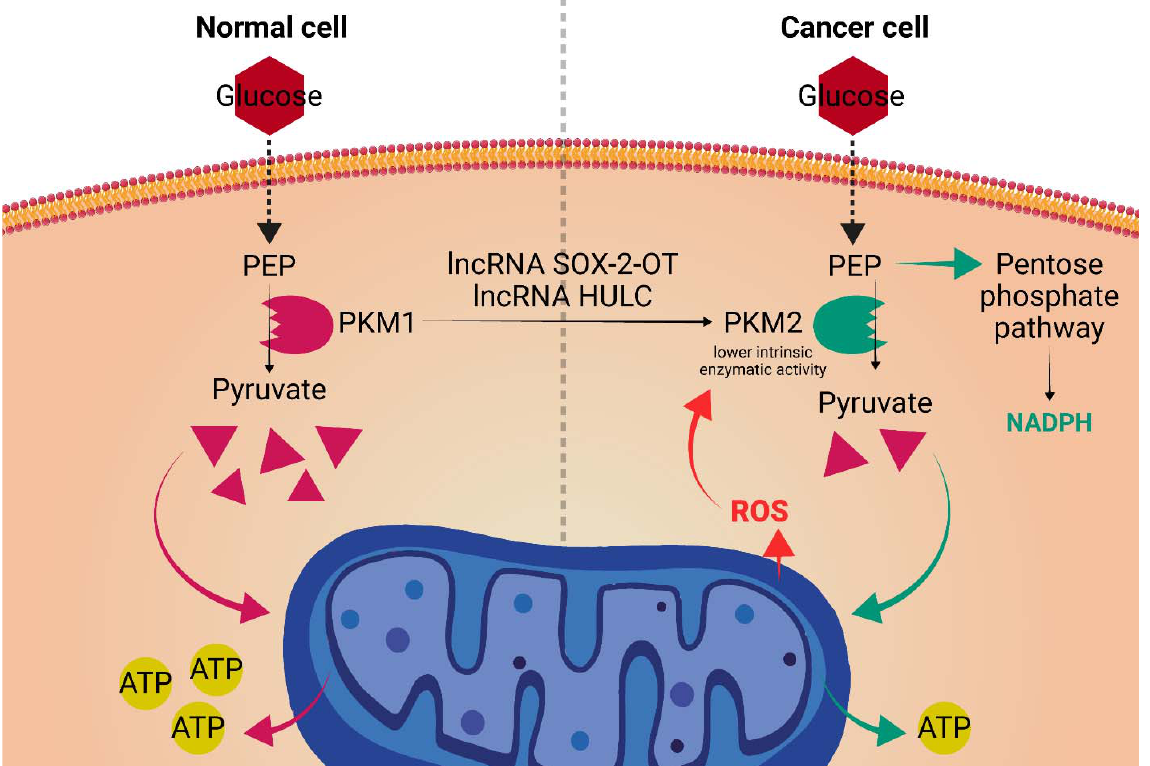
Figure 4. LncRNAs’ role in the Warburg effect: SOX-2-OT and HULC lncRNAs carry out an antioxidant effect by inducing the PKM2 isoform of pyruvate kinase. Given its lower intrinsic enzymatic activity and its susceptibility to inhibition by ROS, the expression of the PKM2 isoform will allow for the synthesis of key antioxidant molecules such as NADPH. PEP, phosphoenolpyruvate; PKM1, pyruvate kinase M1 isoform; PKM2, pyruvate kinase M2 isoform.